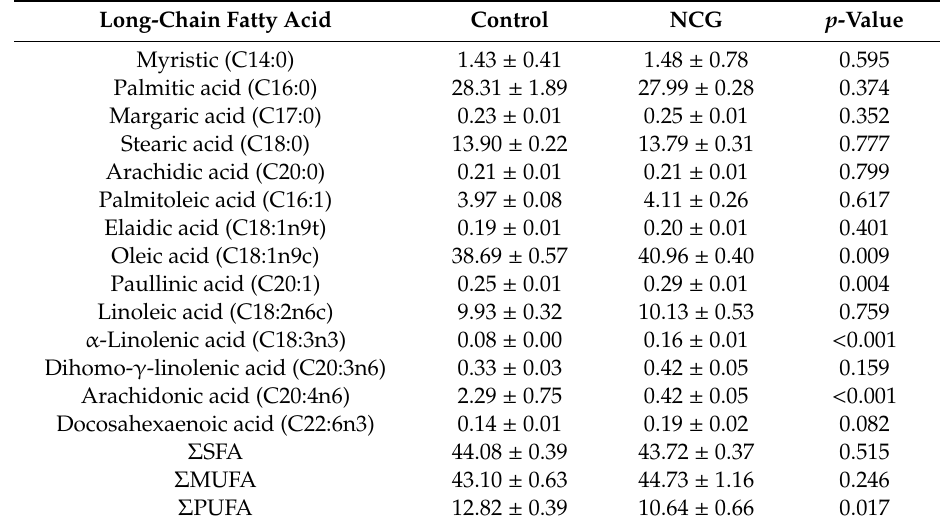
Values are presented as means ± SEM, n = 6. Table 4. E ff ect of dietary N- carbamylglutamate on long-chain fatty acid composition (% of total fatty acids) in the longissimus dorsi muscle of Ningxiang pigs.